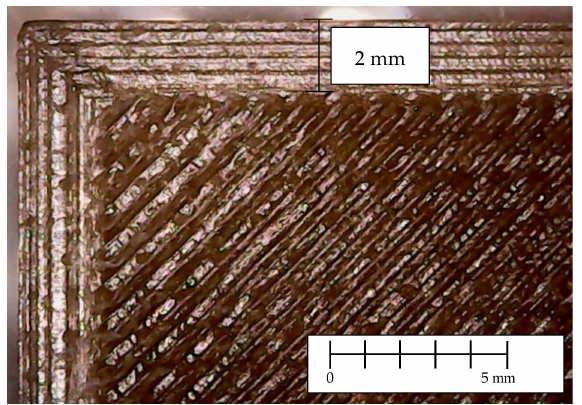
243 Figure 6. Detail of the outer wall and raster of a 3D printed specimen. Figure 6. Detail of the outer wall and raster of a 3D printed specimen.